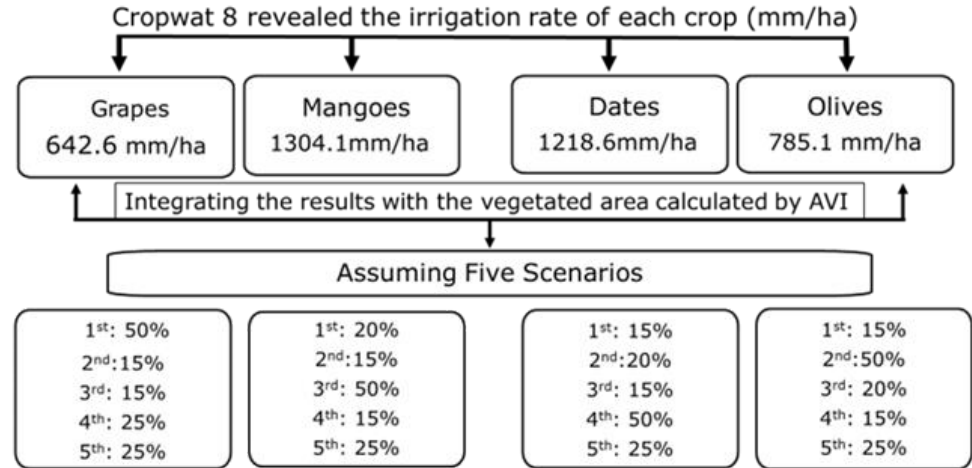
Figure 8. The results of the analysis with Cropwat 8 and the proposed scenarios. Table 2. The effective rain (EFF), potential crop evapotranspiration (ETC), and irrigation required (IR), for each crop type.